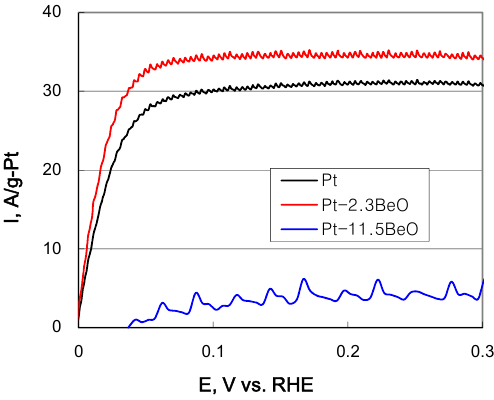
Figure 3. Linear sweep voltammogram of carbon-supported Pt and Pt–BeO.